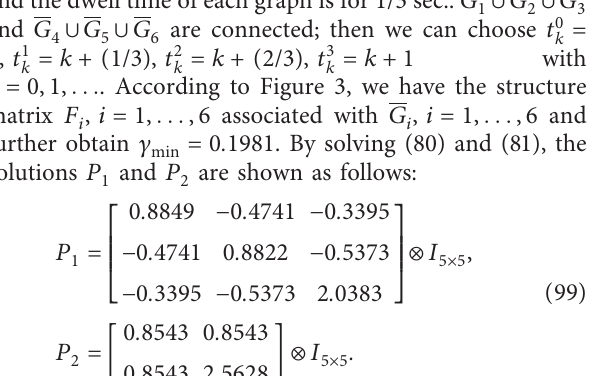
and disturbance estimation 􏽢 d 3